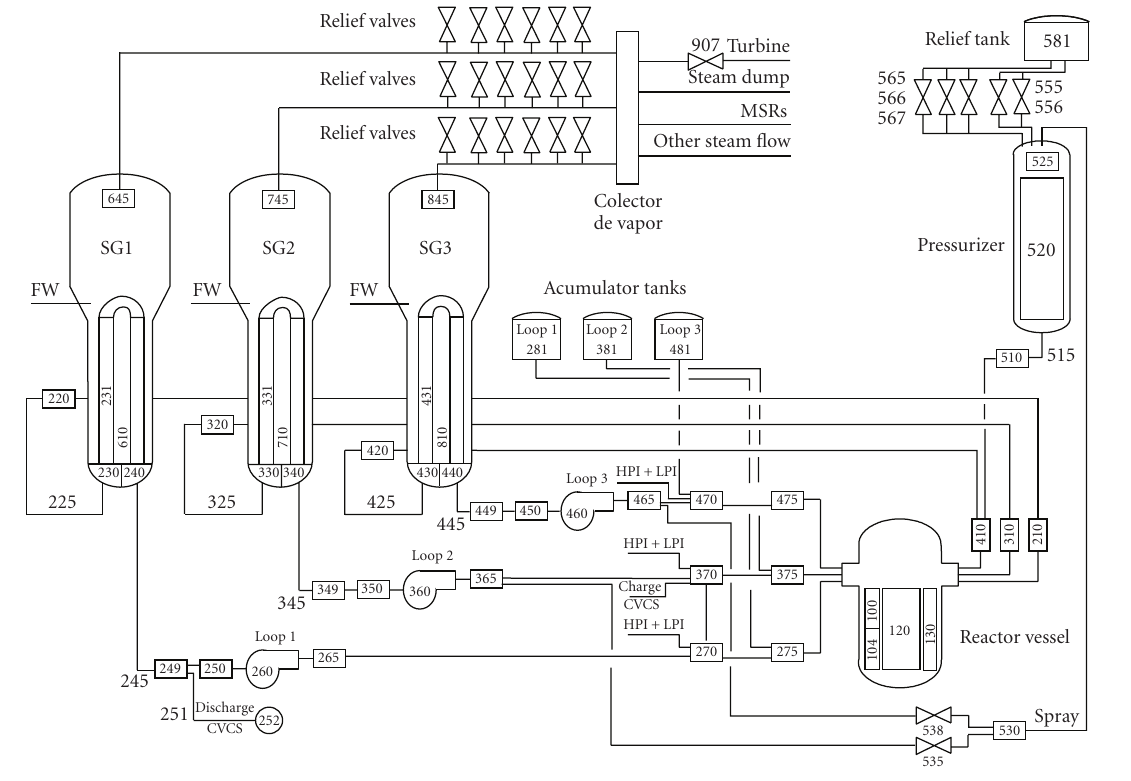
Figure 1: Main nodalization diagram of the Asc´o plant.